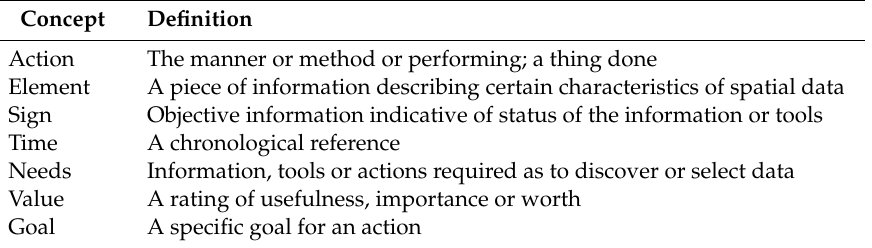
Table 1. Reference codes used in Protocol Analysis